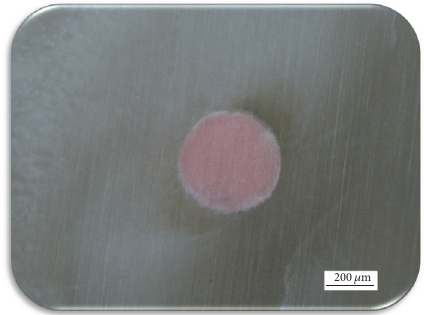
Figure 2: A representative cross section of a root canal filling using the continuous wave technique and Elements Obturation Units (EOU Group), section A.